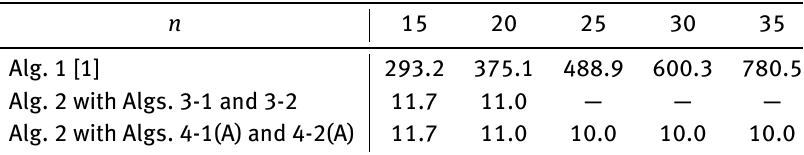
Table 4: Numbers of iterations of Algorithms 1 and 2 for T with low symmetry. T were generated from a = (1, 1, 1) , b = (100, 100, 100) , and c = 1 in (17) – (19) , and the size of T is n 3 × n 3 . The symbol “—” means that the algorithm did not con- verge to the minimum singular values of T .